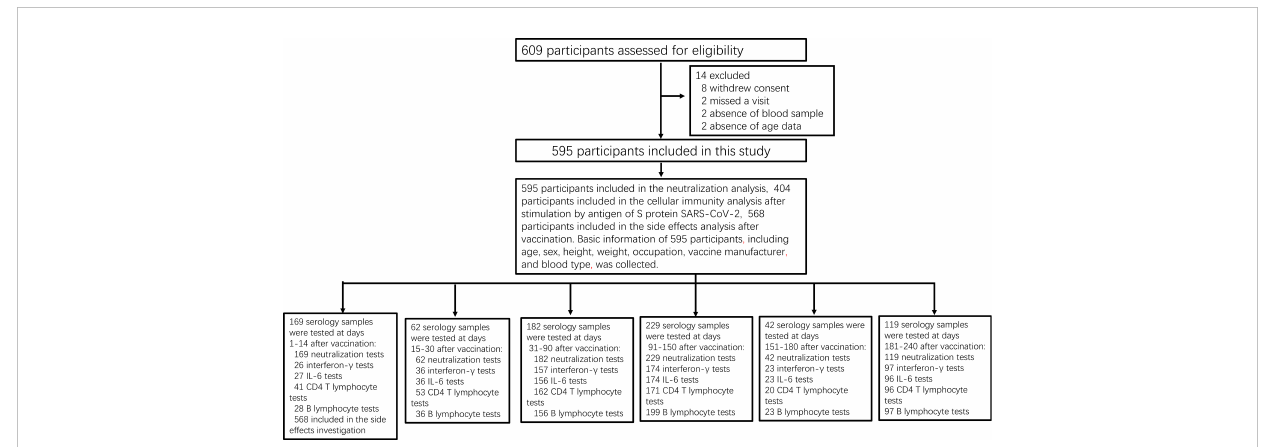
FIGURE 1 Study pro fi le. Prospective cohort of Chinese individuals immunized with the inactivated vaccine and serological assays. Following vaccination, the participating medical staff of Henan Provincial People ’ s Hospital and Zhengzhou Municipal Traditional Medicine Hospital, and workers of the Henan Electric Power Exploration Company in central China were followed up monthly for 8 months between June 19, 2021, and April 30,